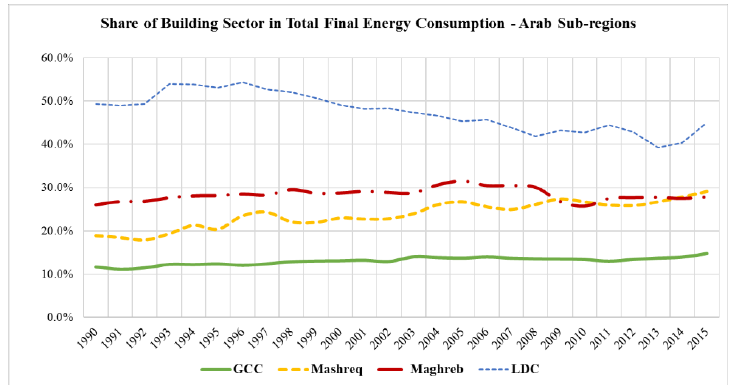
Figure 9. Annual share of the building sector of the overall total final energy consumption (TFEC) for the Arab sub-regions.